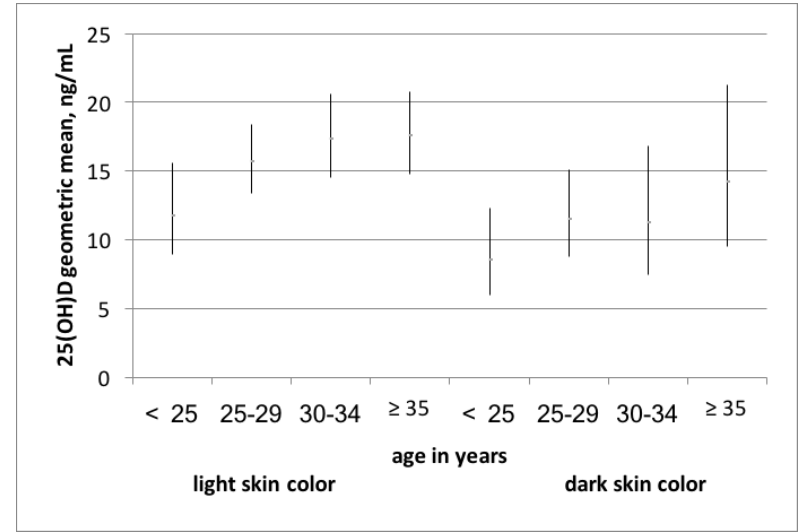
Women with light skin color had the highest vitamin D levels in summer and the lowest in